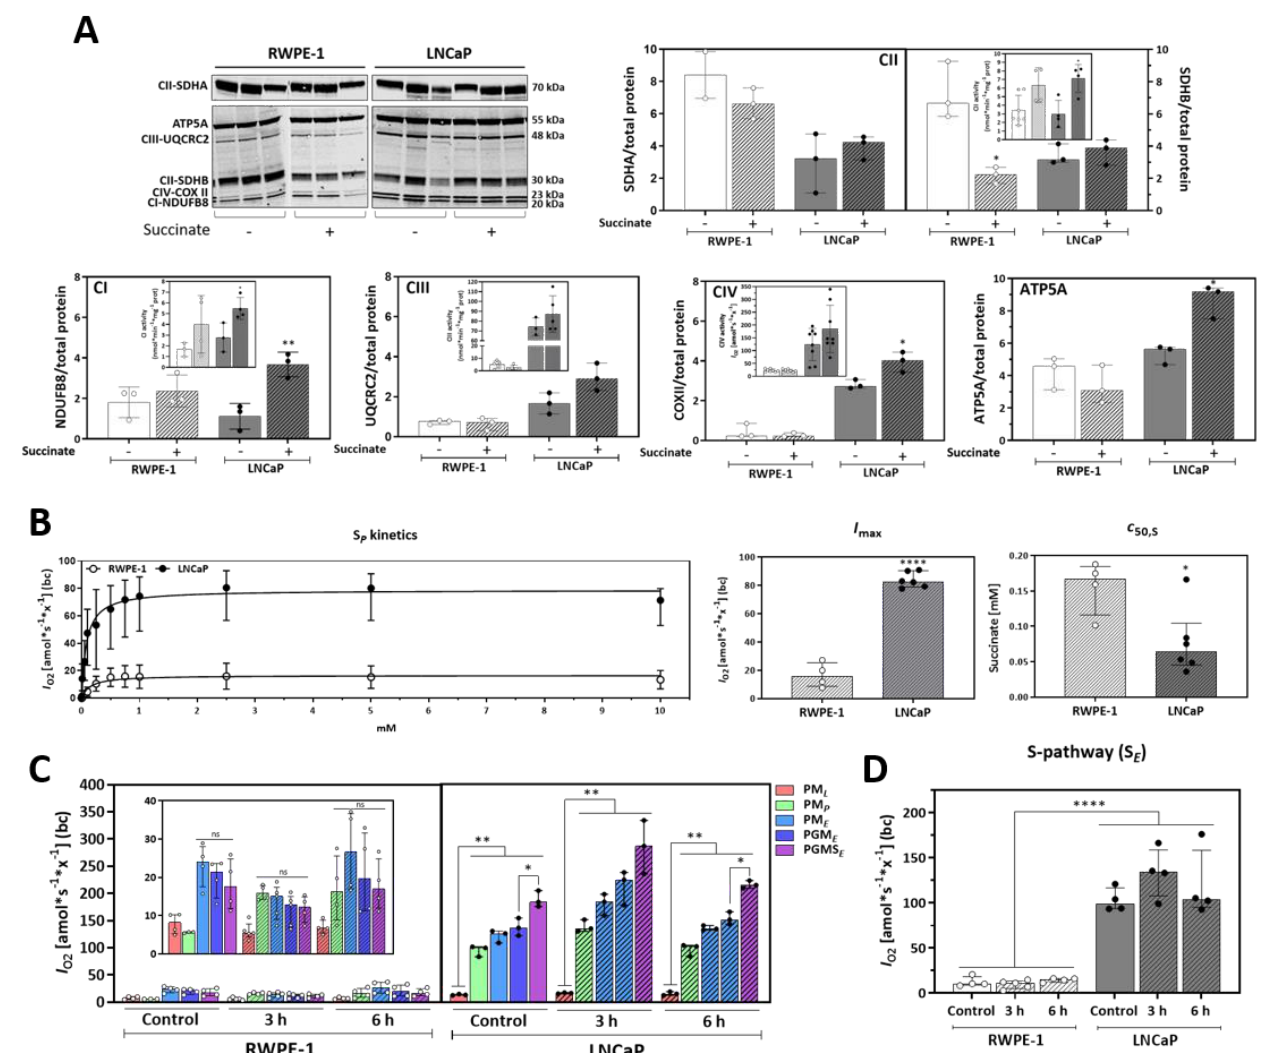
Figure 4. Effect of succinate on mitochondrial function. ( A ) Protein expression of subunits of electron transfer system (ETS) complexes NDUFB8 (CI), SDHA and SDHB (CII), UQCRC2 (CIII), COX II (CIV) and ATP5A (ATP synthase) ( N ≥ 3; n = 2). Cells were incubated for 6 h with 5 mM succinate (+) or vehicle (-) before harvest. Proteins were normalized by total protein content within each protein extract of RWPE-1 and LNCaP cells. Inserts represent CI, CII, CIII (nmol * min −1 * mg −1 protein) and CIV activities per cell [amol*s −1 *x −1 ] with or without 5 mM succinate incubation for 6h. N ≥ 3. A representative western blot image is shown on top. ( B ) Hyperbolic kinetics of succinate-linked OXPHOS capacity (S P ) in MiR05 buffer. After stabilization of ROUTINE respiration, the following chemicals were added: digitonin (5 µg/mL), rotenone (0.5 µM), ADP (1 mM), and succinate in the range of 10 µM–10 mM. I max represents maximum O 2 flow at kinetic saturation by succinate ( N ≥ 4) and c 50,S is the concentration of succinate at which 50% of I max is obtained ( N ≥ 4). ( C ) HRR analysis employing SUIT-001 O2 ce-pce D003 in RWPE-1 and LNCaP cells incubated with 5 mM succinate for 3 or 6 h. PM L , LEAK-compensatory respiration ( L ) supported by pyruvate (P) and malate (M); PM P , pyruvate & malate supported OXPHOS capacity ( P , after addition of ADP); PM E , pyruvate & malate supported ET capacity ( E , after uncoupler titration); PGM E , capacity supported by pyruvate, malate & glutamate (G); PGMS E ET capacity supported by pyruvate, malate, glutamate & succinate (S) ( N ≥ 4). Insert represents a zoom in of the RWPE-1 data. ( D ) Succinate (S-) pathway respiration after addition of PGMS and subsequent inhibition of CI with Rot (S E ) in cells incubated with 5 mM succinate for 3 or 6 h. All measurements at 37 ◦ C in MiR05 with 1.0 × 10 6 x/mL of RWPE-1 or LNCaP cells in the O2k-chamber. Units are O 2 flow per cell counts, I O2 [amol*s − 1 *x − 1 ], where “x” represents the elementary unit of cell count [29], baseline-corrected (bc). Median and IQR. Two-tailed unpaired t -tests between control and each time-point or between cell lines ( A , B ) and two-way ANOVA for multiple comparisons ( C , D ). * p = 0.05, ** p < 0.001, **** p <